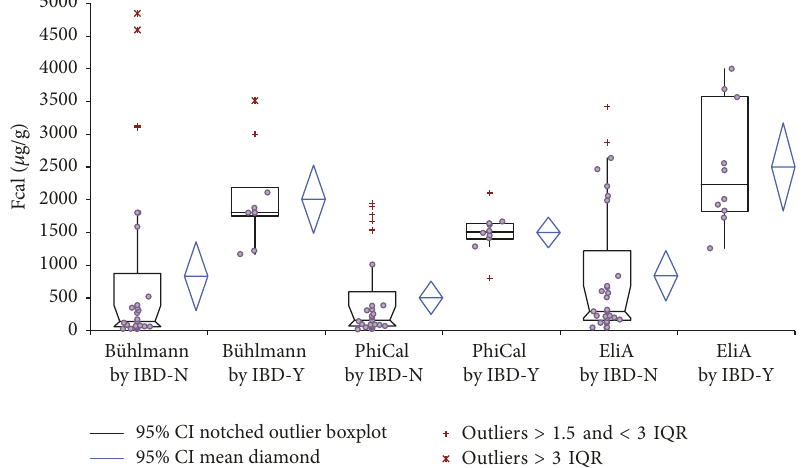
Figure 3: FCal in predicting relapse in pediatric IBD patients . FCal levels were assessed in 40 pediatric patients with IBD to evaluate the capacity of FCal to determine relapse. FCal levels ( 𝜇 g/g) were analyzed using B¨uhlmann Calprotectin POCT, PhiCal Calprotectin-EIA, and Phadia 250 EliA-Calprotectin with positive (Y) or negative (N) colonoscopy of active